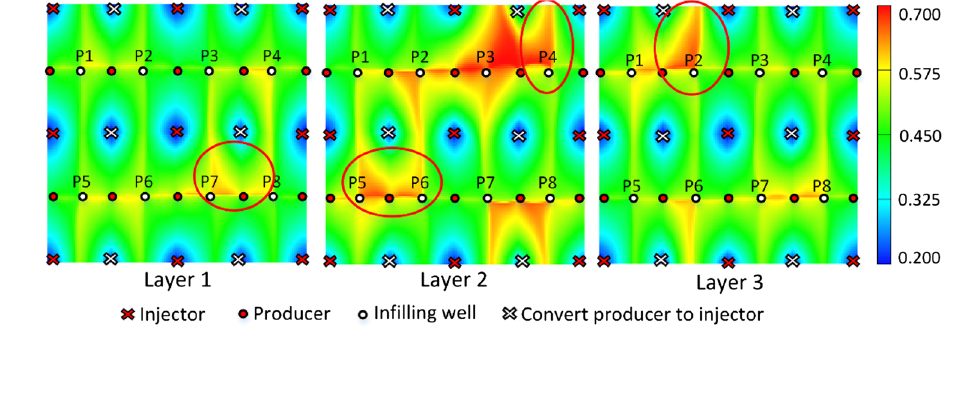
distribution under proposed optimization